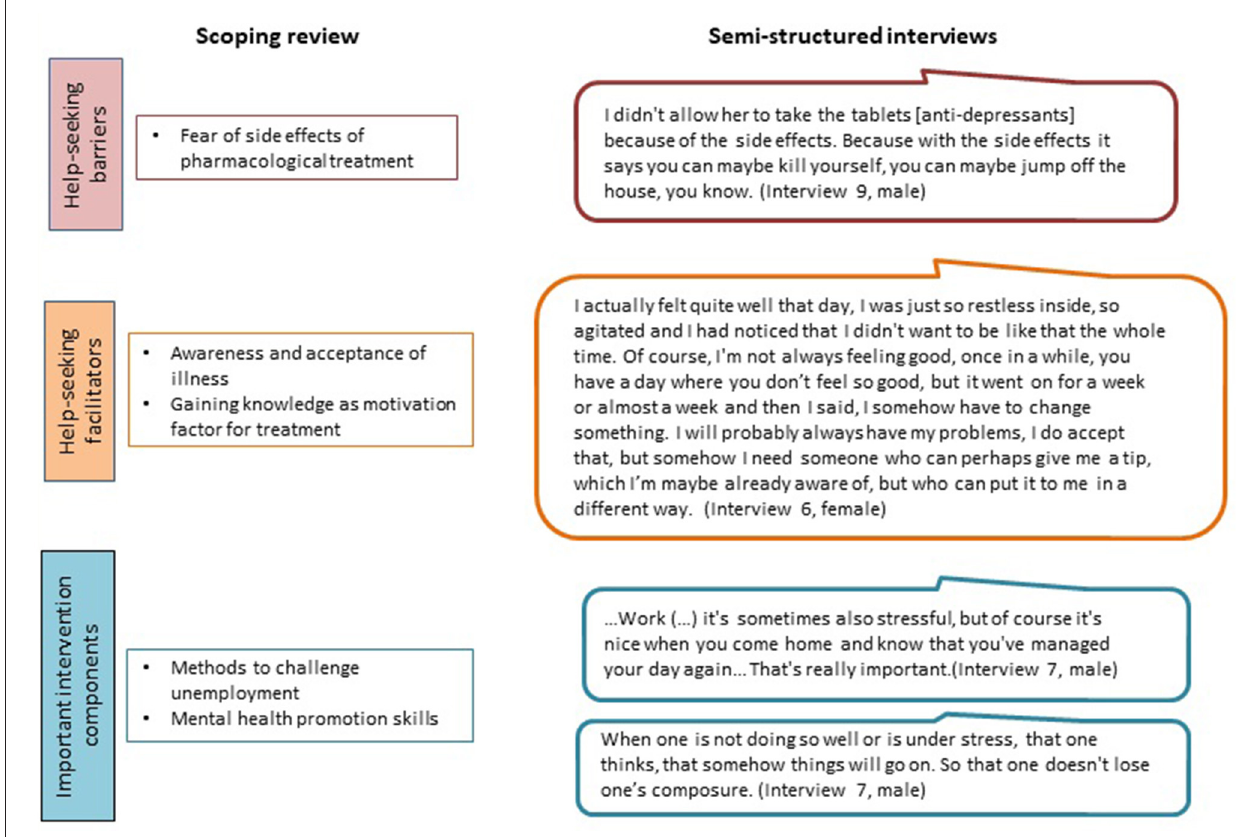
FIGURE 3 | Triangulation of scoping review and interview